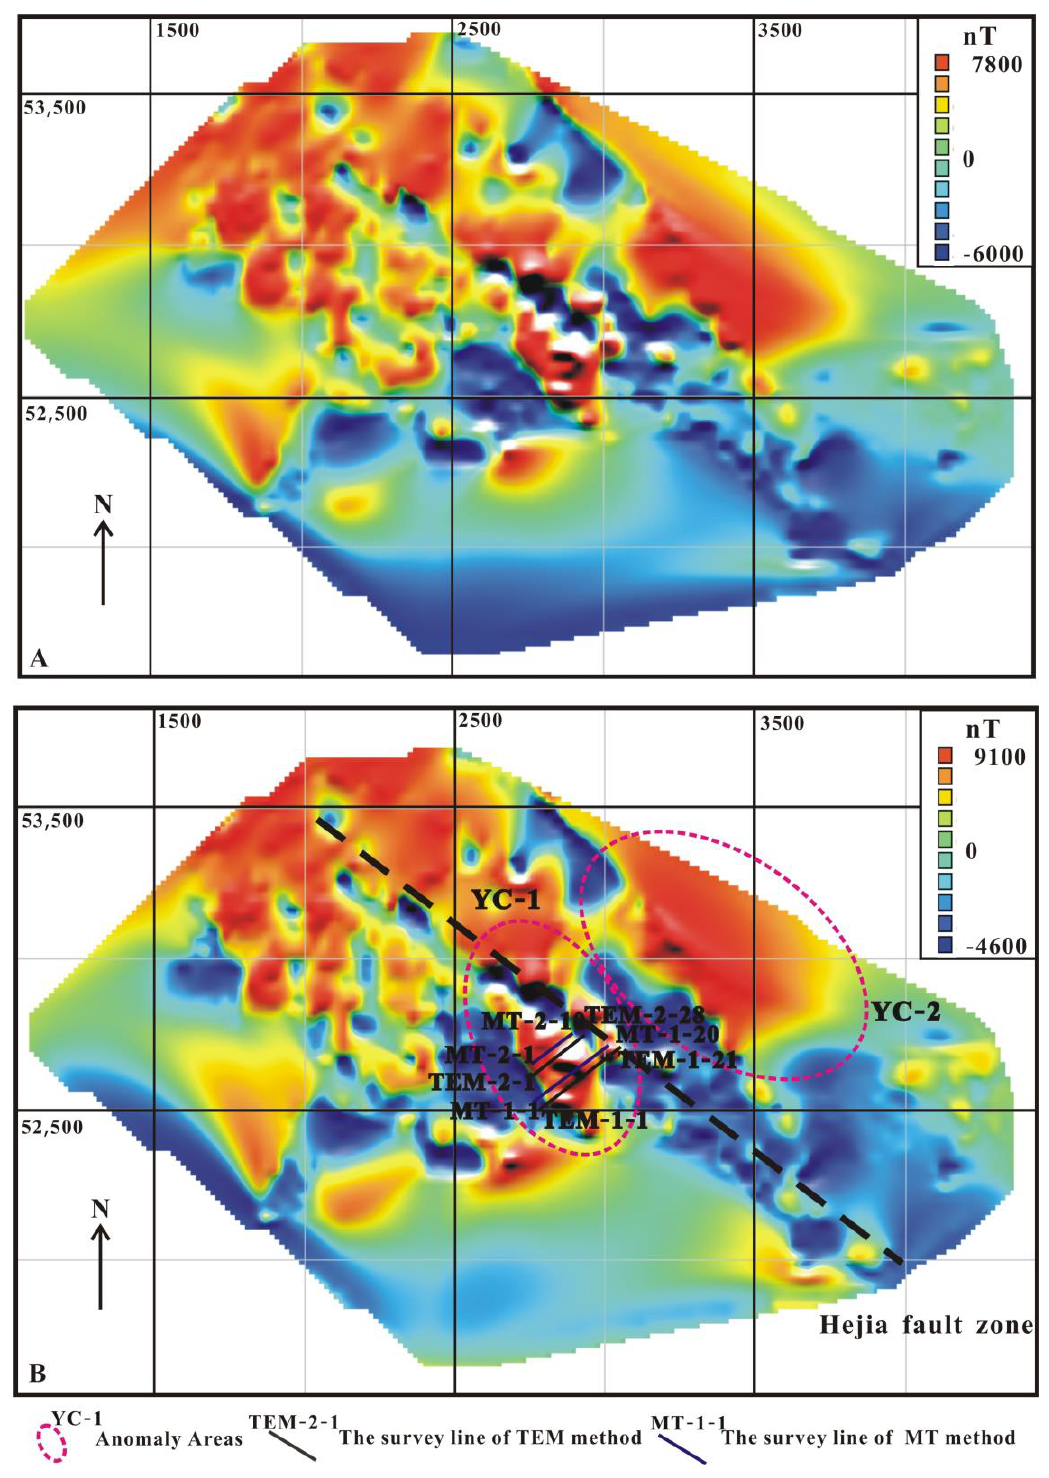
Figure 5. The magnetic anomaly map of the detection area in the Gongchangling iron ore concentration area. ( A ) Before reduction-to-the-pole treatment; ( B ) After reduction-to-the-pole treatment.